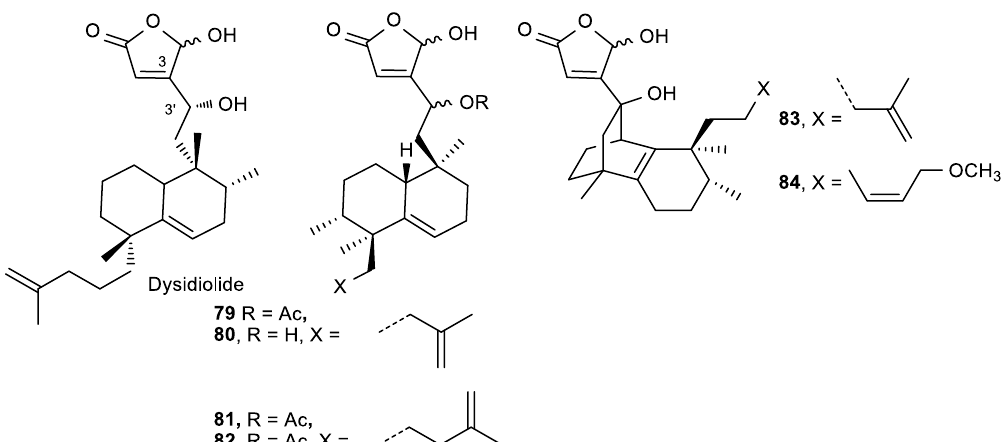
Figure 31. Compounds structurally related to dysidiolide as potential. Table 31. The antitumor activities of dysidiolide derivatives.